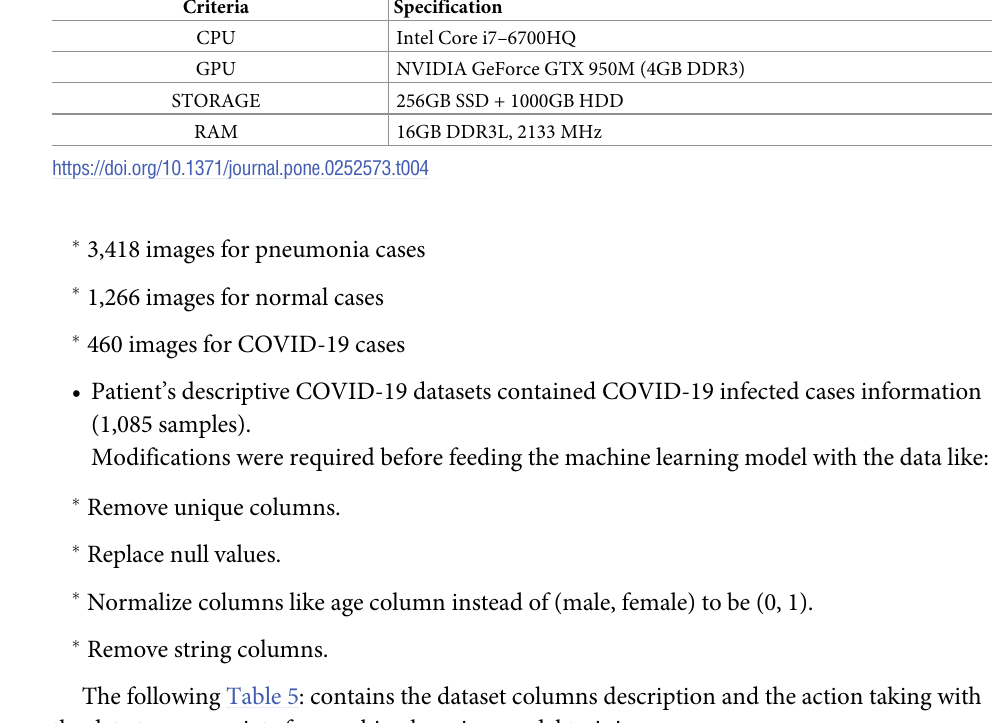
The following Table 5: contains the dataset columns description and the action taking with the data to appropriate for machine learning model training.